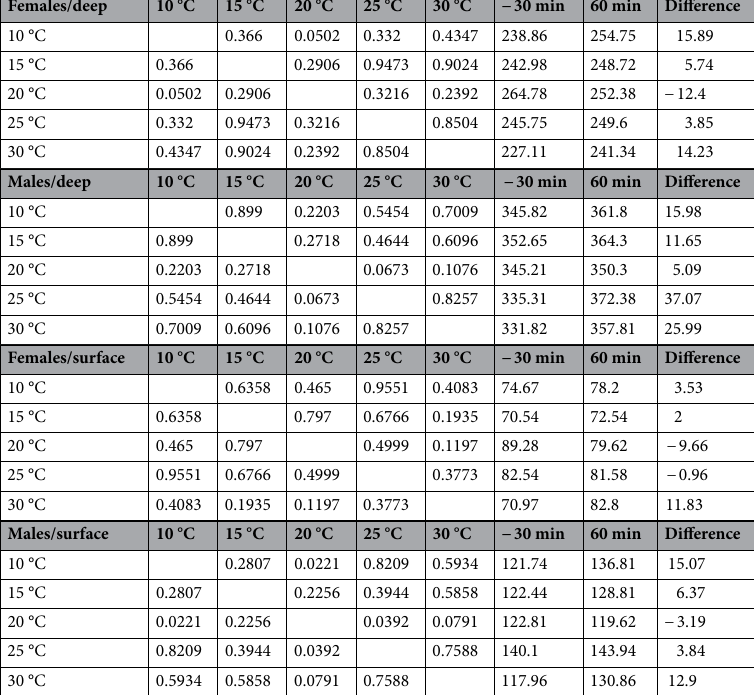
Table 2. p -values of blood flow 60 min after cooling at different temperatures and mean flow values before cooling and 60 min after cooling.